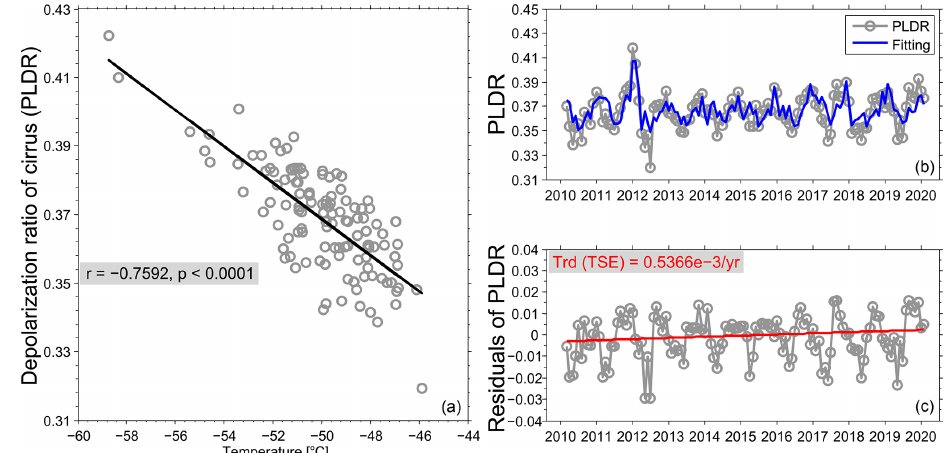
Figure 8. (a) The grey circles stand for the correlation between the monthly medians of cirrus PLDR and the corresponding ambient temperatures, and the black line for the linear fitting line derived from all data points. (b, c) The monthly medians of cirrus PLDR during the period from March 2010 to February 2020 are shown in grey and the regressed values with the first-degree polynomial are shown in blue (b) ; the residuals after removing the regressed values from the monthly medians of PLDR are shown in grey and the linear fitting line with the Theil–Sen estimator (TSE) method is shown in red, with the long-term trend of 0.54 × 10 − 3 yr − 1 indicated on the plots (c) .